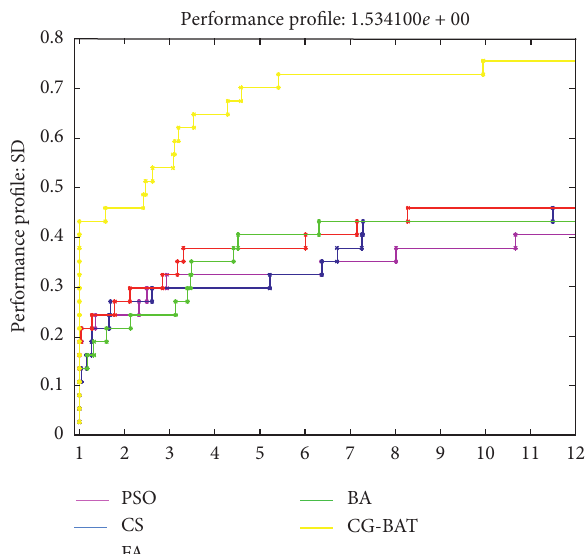
Figure 6: Performance profiles based on SD.